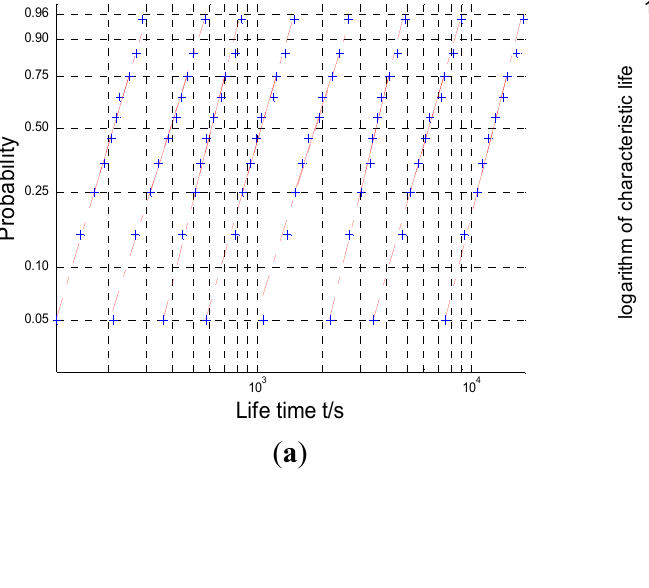
Figure 3. ( a ) Weibull probability chart for different temperatures; ( b ) The fitting line between the logarithm of life characteristic and the reciprocal of absolute temperature